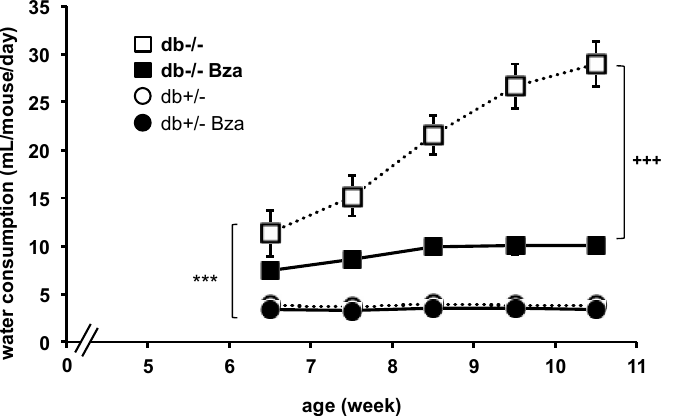
Figure 3. Benzylamine supplementation lowers water consumption in obese/diabetic mice. Each point is the mean ± SEM of n = 12 (7 males/5 females) for db-/- (open squares); 8 (4/4) for Bza-db-/- (closed squares); 9 (6/3) for db+/- (open circles); 5 (2/3) for Bza-db+/- (closed circles). Significant influence of genotype at: *** p < 0.001 for db-/- vs. db+/-; significant difference at: +++ p < 0.001 between db-/- and Bza-db-/- mice.